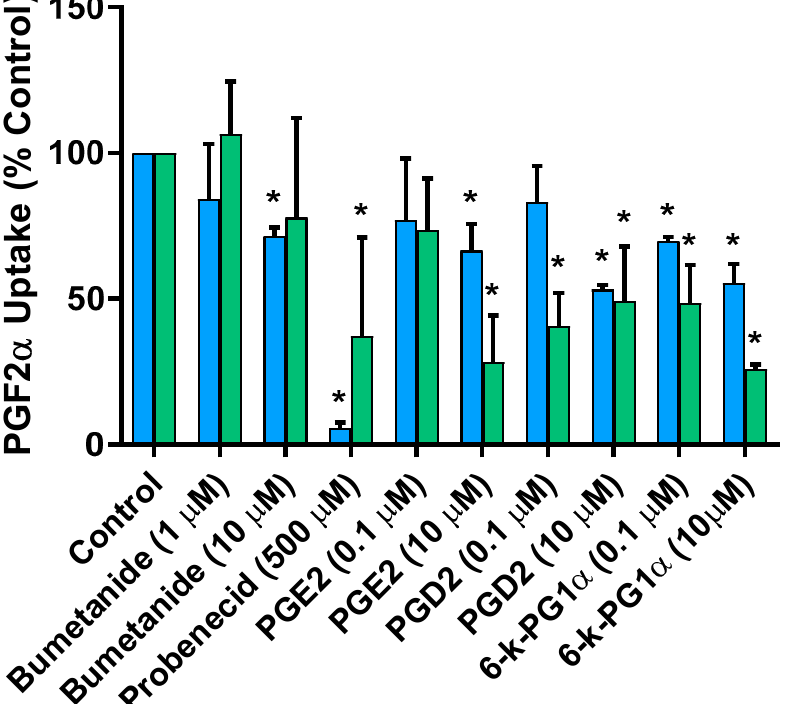
Figure 3. Cis -inhibition assay demonstrating the inhibition of prostaglandin F 2 α (PGF2 α ) uptake by prototypical monocarboxylate transporter 6 (MCT6) substrates (bumetanide and probenecid) as well as other members of the eicosanoid family (PGE2: prostaglandin E2, PGD2: prostaglandin D2, 6-k-PG1 α : 6-keto prostaglandin F1 α ) in murine Mct6 (blue) and human MCT6 (green)-transfected oocytes. Data are presented as mean percent control uptake in the absence of inhibitor ± SD. Experiments performed using 1 nM PGF2 α , pH 7.4, r.t., for 30 min (* p < 0.05 compared to control).